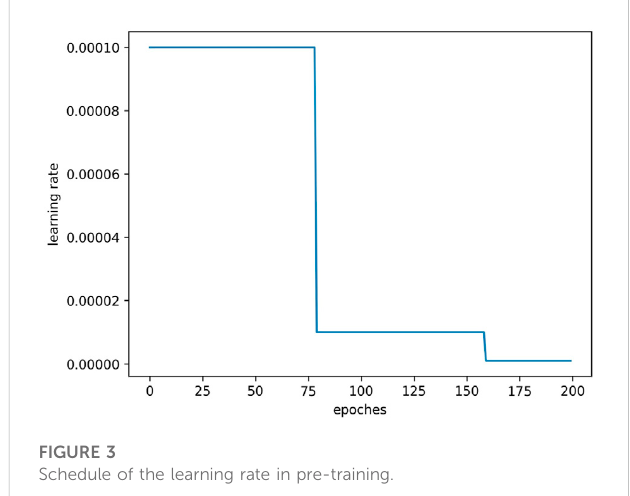
FIGURE 3 Schedule of the learning rate in pre-training.